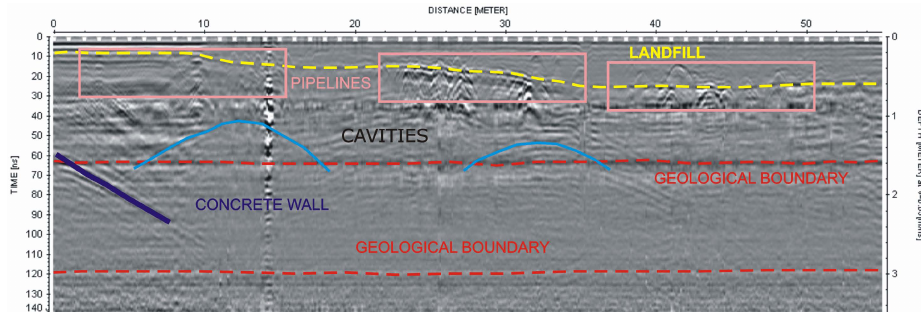
Fig. 4. BL1 georadar profile carried out along Belvedere street.